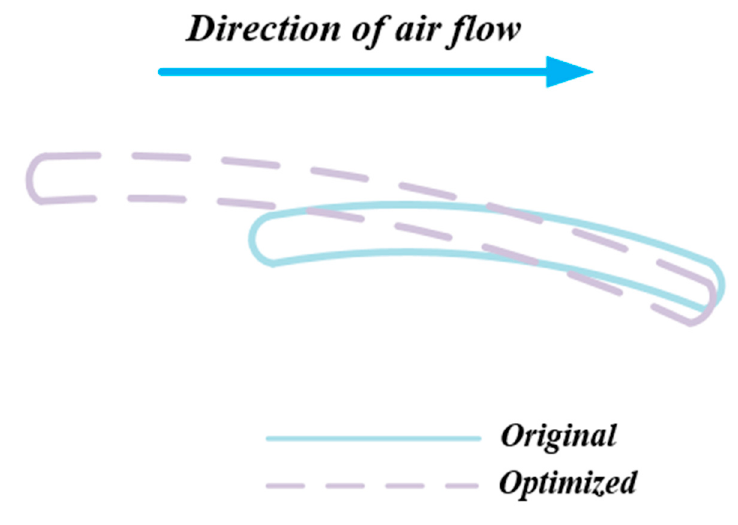
Figure 12. A before and after comparison optimization of the rear guide vane.